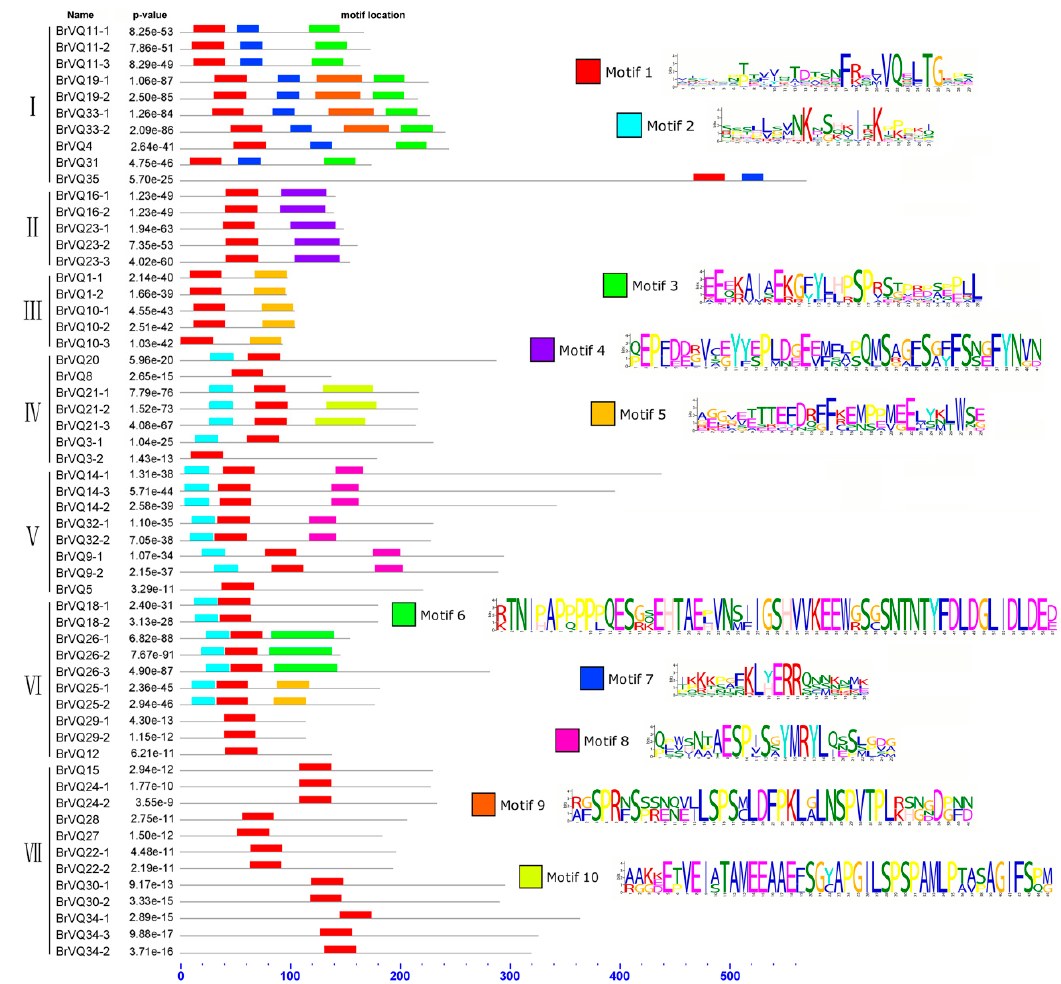
Figure 3. Motif analysis of the VQ proteins in Chinese cabbage. Distribution of the BrVQ conserved motifs in Chinese cabbage was analyzed by the online tool MEME.